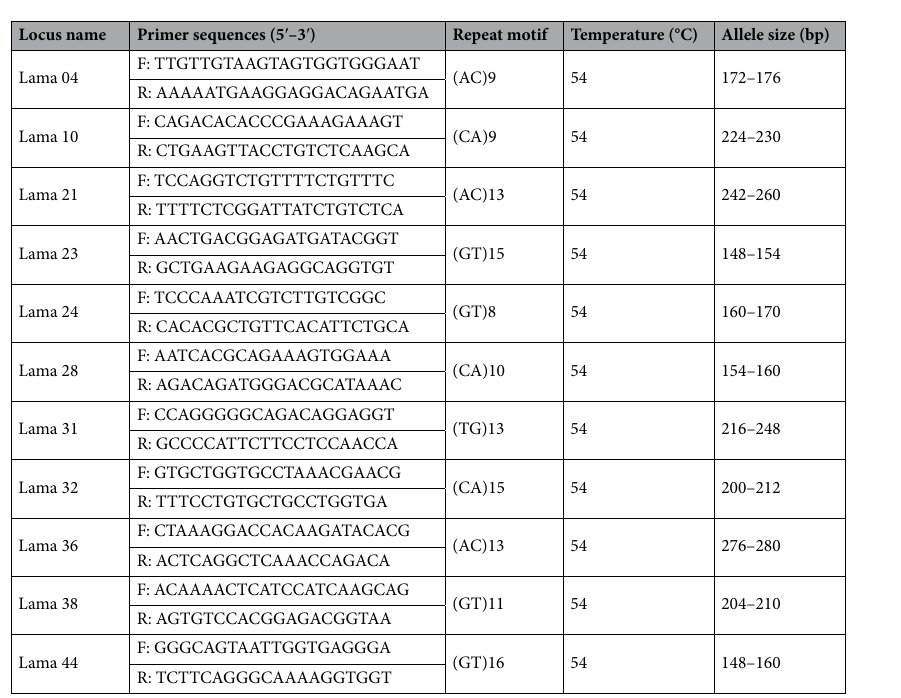
Table 7. Characterization of L. maculatus microsatellite